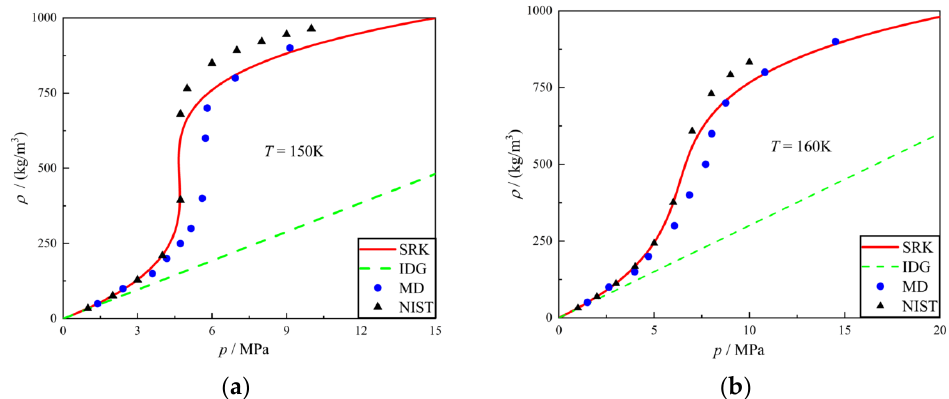
Figure 8. Results of molecular dynamics of argon compared with SRK EOS, ideal gas EOS and NIST data at different temperatures: ( a ) T = 150 K; ( b ) T = 160 K.